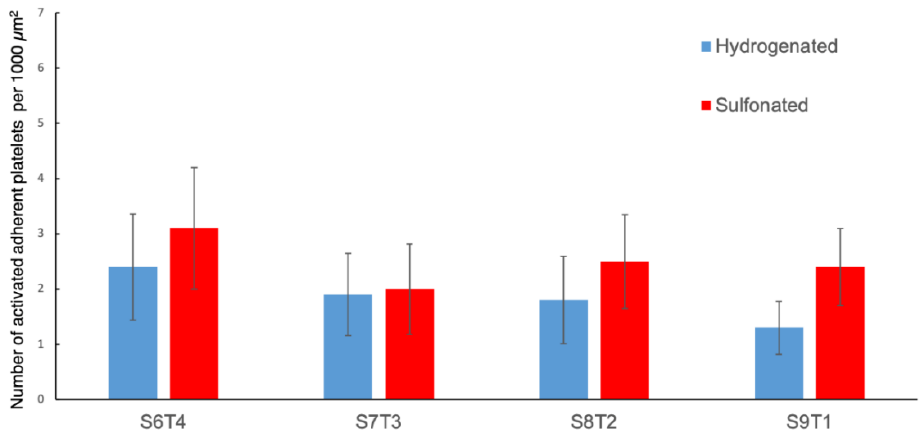
Figure 9. Number of activated (i.e., not in a round shape) adherent platelets per 1000 µm 2 on the hydrogenated and sulfonated block copolymers.